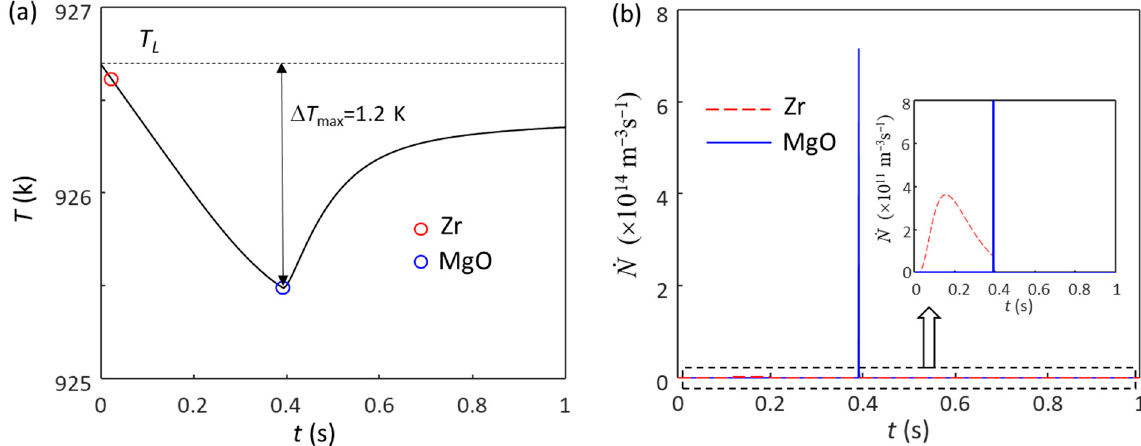
Figure 6. The calculated ( a ) cooling curve and ( b ) grain initiation rate of sheared Mg-0.45Zr alloy with a small number of Zr particles ( N 0 = 1 × 10 11 m − 3 ) at a cooling rate of 3.5 K/s. The red and blue circles mark the onset of grain initiation on solid particles induced by Zr and MgO particles, respectively.